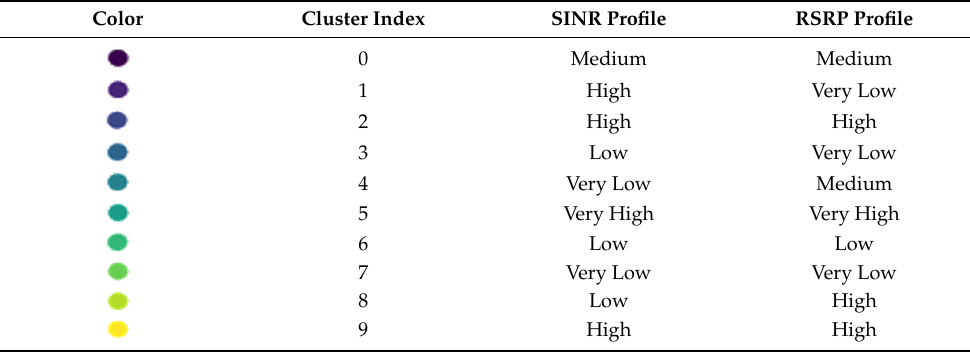
Figure 4. Network metric clustering results (PCA) colored by cluster. Table 4. Clustering result legend including color, index, and SINR/RSRP profile quality class.